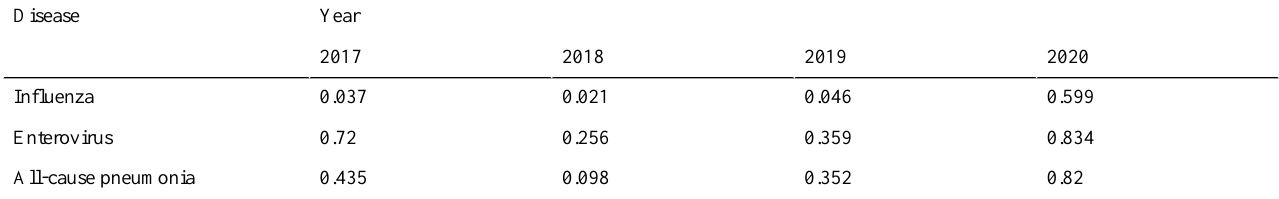
Table 2. Regression analyses results (R 2 ) for 2017-2020.